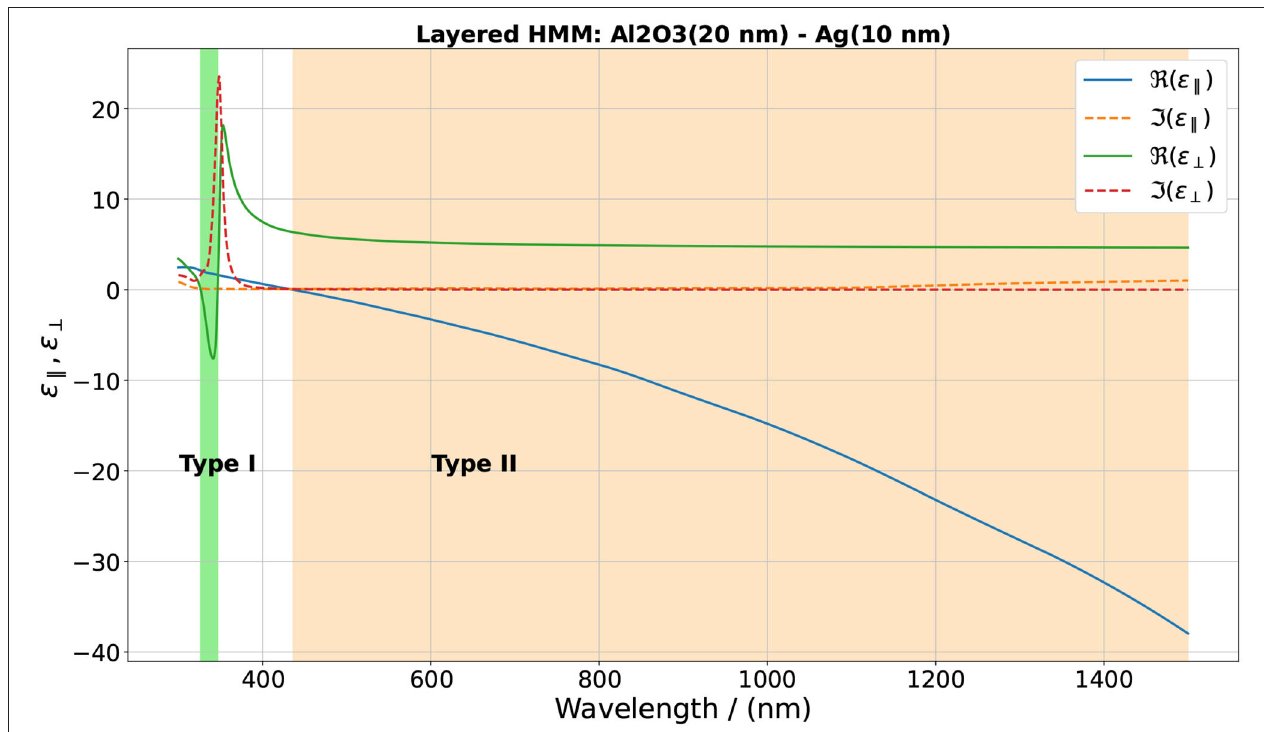
FIGURE 6 | Dielectric functions of a plasmonic-dielectric layered medium calculated using the effective medium theory. Each bilayer is composed of silver (10 nm) and aluminum oxide (20 nm). The permittivity of silver was obtained from the optical constants from Johnson and Christy (1972). The spectral regions labeled with Type I and Type II are the regions where the real part of perpendicular and parallel parts of the dielectric function become negative,